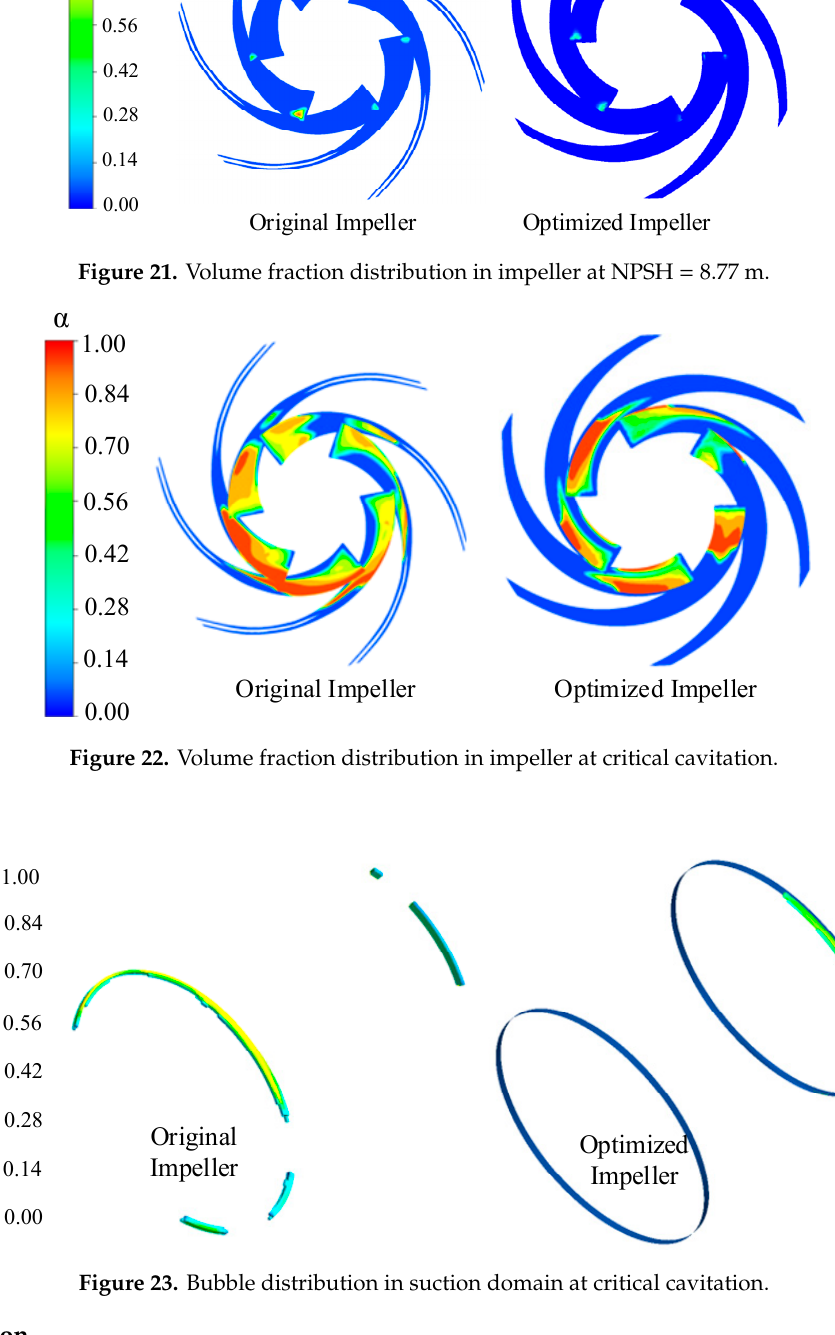
Figure 23. Bubble distribution in suction domain at critical cavitation.